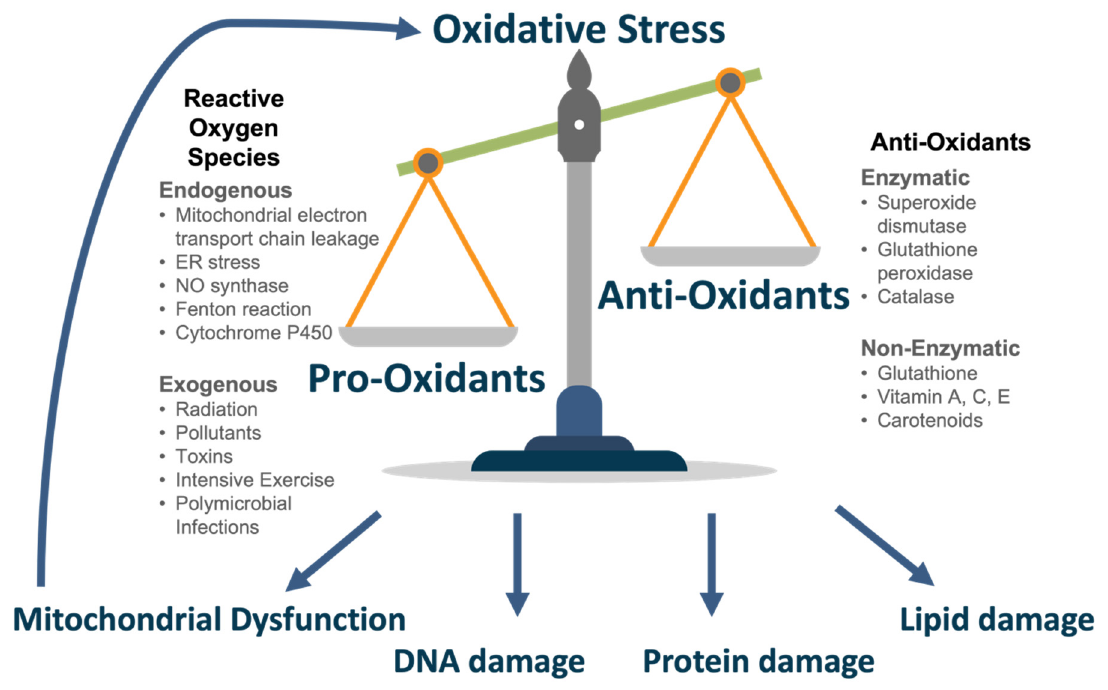
Figure 2. Oxidative Stress.